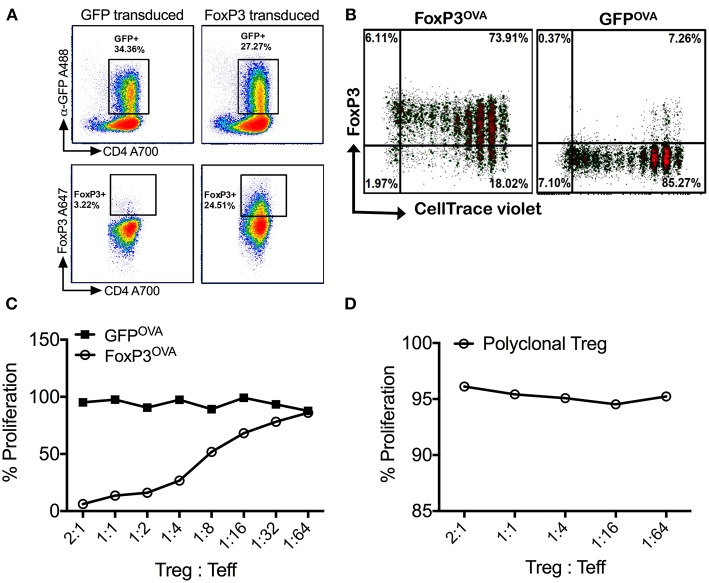
Retrovirally transduced cells stably express FoxP3 and are suppressive in vitro. (A) Isolated splenic murine CD4+CD25− cells transduced with the MIGR-mFoxP3 vector strongly expressed GFP (upper panel), which correlated with intracellular FoxP3 expression (lower panel). Cells transduced with the control vector MIGR1 expressed only GFP. (B) FoxP3 transduced cells from DO11.10 Rag2−/− mice were labeled with CellTrace Violet, adoptively transferred into wt BALB/c mice and recipients were injected with 100μg OVA323−339 peptide by the i.p. route. Spleens were recovered after 3 days. Robust proliferation of donor transgenic cells (FoxP3OVA) without compromise in FoxP3 expression was observed. Control DO11.10+ cells (GFPOVA) proliferated in response to OVA323−339 peptide administration but did not express FoxP3. (C) FoxP3OVA cells strongly suppressed the proliferation of CellTrace Violet labeled DO11.10+ CD4+CD25− responder cells cultured with CD4− total splenocytes and stimulated with OVA323−339 peptide. Control GFP transduced cells (GFPOVA) or (D) freshly isolated tTregs of a polyclonal specificity did not suppress the proliferation of OVA323−339 stimulated responder T cells. Data is a single representative of at least 2 independent experiments.